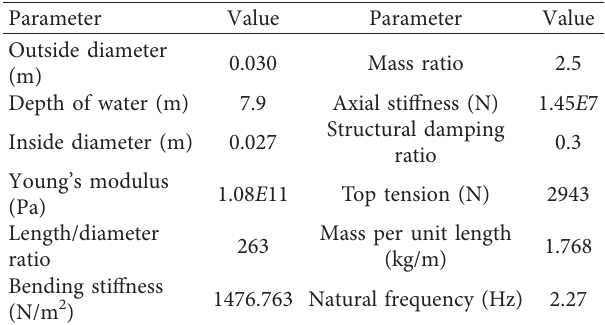
Table 1: Parameters of the riser model in